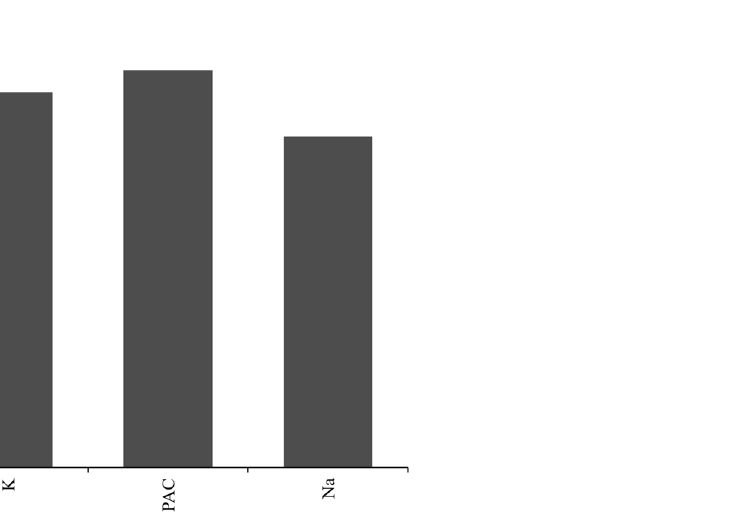
Figure 5. Relative importance of three variables for predicting unilateral subtype of primary aldosteronism in feature-selected random